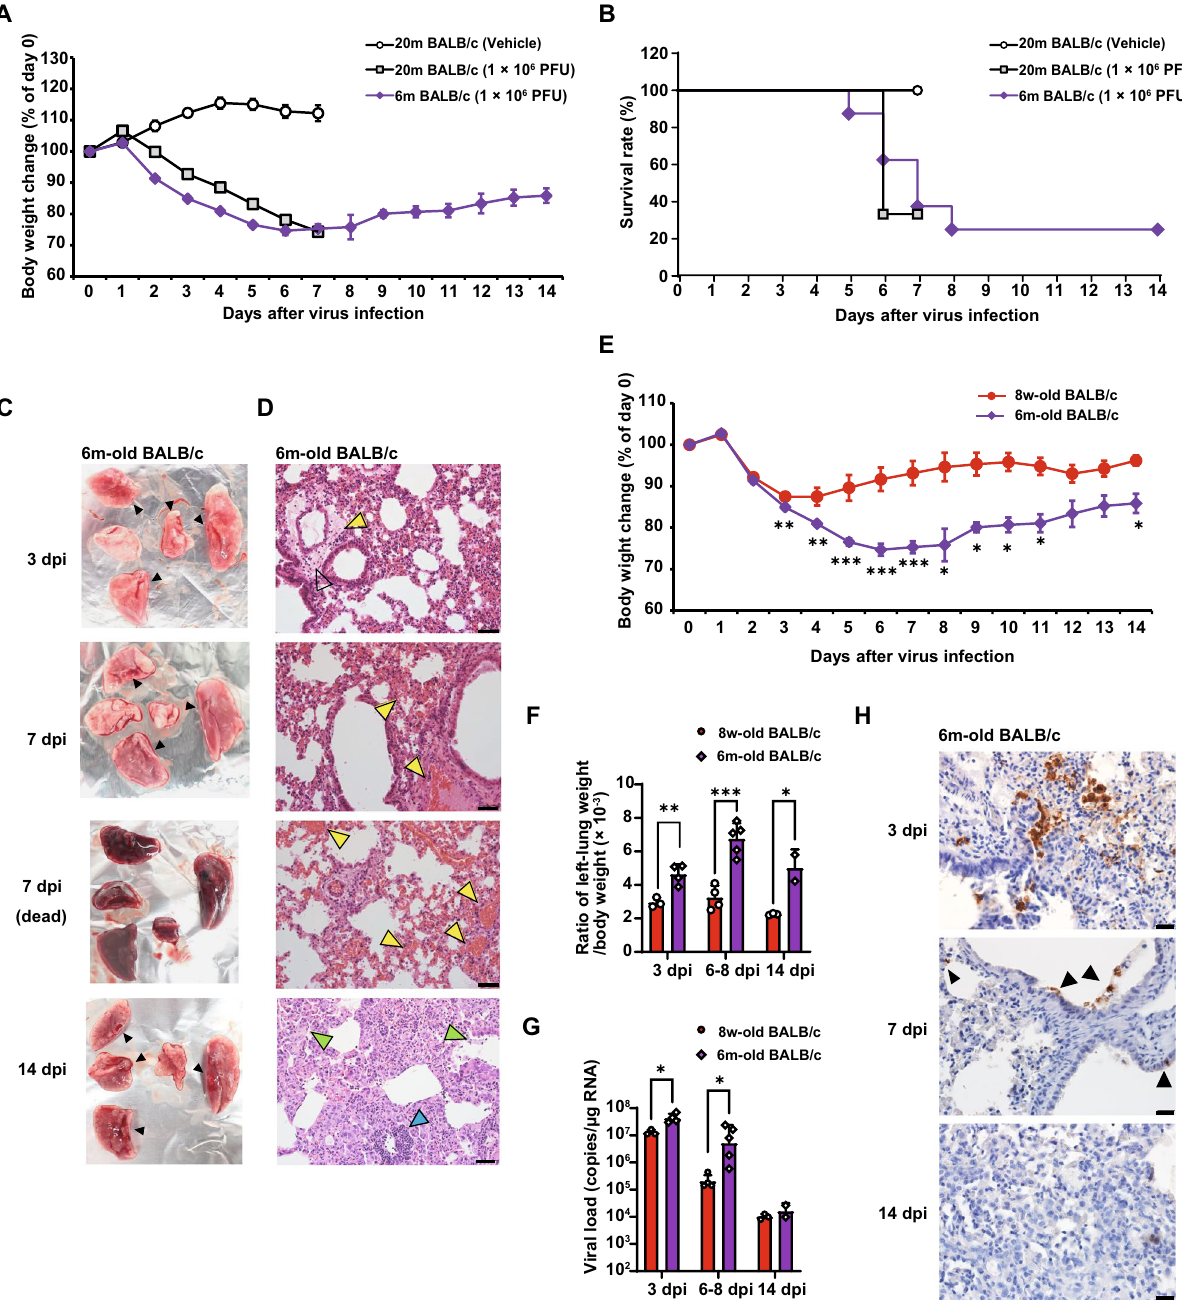
Figure 2. Aged BALB/c mice that succumbed to infection with the SARS-CoV-2 B.1.351 variant, with drastic weight loss, high viral replication, and severe pneumonia. Six-month-old (n = 12) and 20-month-old BALB/c mice (n = 3) were infected intranasally with 1 × 10 6 PFU of the TY8-612 strain. Body weight was monitored daily ( A ). The survival rate was recorded until 7 dpi in 20-month-old BALB/c mice and 14 dpi in 6-month-old BALB/c mice ( B ). ( A ) Data are presented as mean ± SEM. ( C ) Lung macroscopic appearance on the indicated days. Black arrowheads indicate dark red lesions. ( D ) Representative sections (hematoxylin and eosin staining. section thickness: 4 μm) from 6-month-old BALB/c mice at 3, 7, or 14 dpi. For all micrographs, the original magnification was 200 × (scale bar = 50 μm). Yellow arrowheads indicate perivascular edema (top panel), hemorrhages and congestion (2nd and 3rd panels). Light green arrowheads indicate an activated macrophage accumulation (bottom panel). Light blue arrowhead indicates lymphoid infiltration (bottom panel). ( E ) Comparison of temporal changes in body weight between 8-week-old (young) and 6-month-old (aged) BALB/c mice. The body weight data of young and aged BALB/c mice were the same as those in Figs. 1B and 2A, respectively. Data are presented as mean ± SEM. P-values were calculated using a two-tailed unpaired Student’s t -test. ( F ) Ratio of wet left-lung weight per initial body weight (day 0) compared between young (n = 3–4 per time point) and aged (n = 2–5 per time point) groups. P-values were calculated using a two-tailed, non-paired Student’s t -test. ( G ) Viral loads of lung homogenates determined via RT-qPCR for the SARS-CoV-2 N protein gene and compared between young (n = 3–4 per time point) and aged (n = 2–5 per time point) groups. P-values were calculated using a two-tailed unpaired Student’s t -test or the Mann–Whitney U test. ( H ) Detection of virus-infected cells in the lungs at 3, 7, or 14 dpi (SARS-CoV-2 nucleocapsid protein [brown staining, original magnification 400 × , scale bar = 20 μm]). Black arrowheads indicate the infected cells. Nuclei were stained with